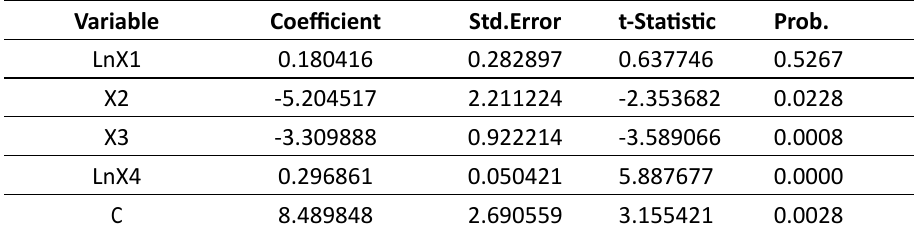
Table 3: Long Term Estimation Equation